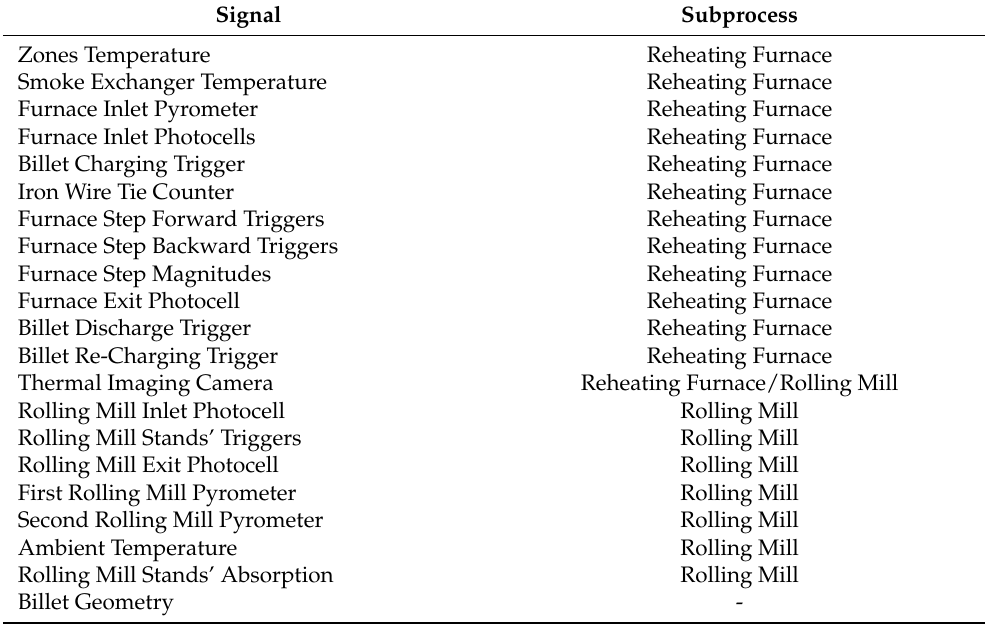
Table 3. Data that were selected for the proposed study.